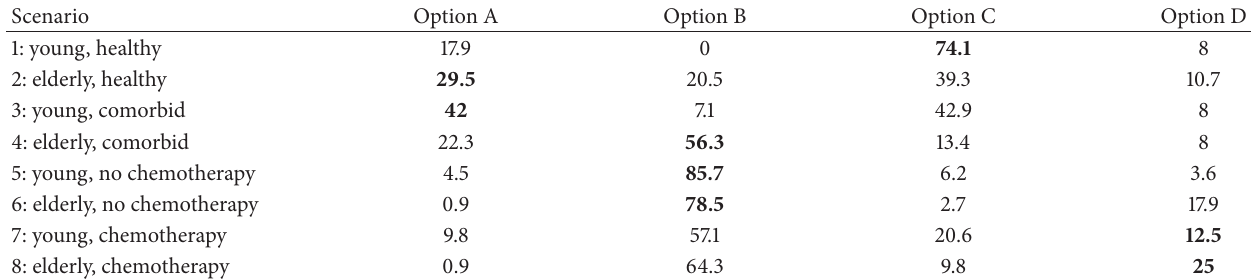
Table 2: All respondents’ management decisions (measured in proportions, %) based on eight clinical scenarios of malignant large bowel obstruction (detailed in Box 1), with the optimal approach highlighted in bold, as suggested by the 2014 ESGE/ASGE guidelines.